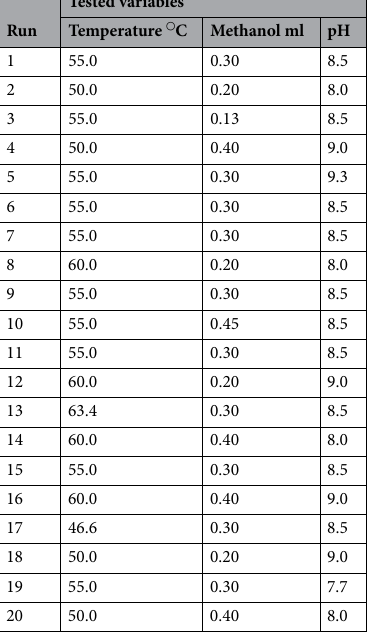
Table 4. Reaction condition variables assayed for the experimental design of the quadratic model.